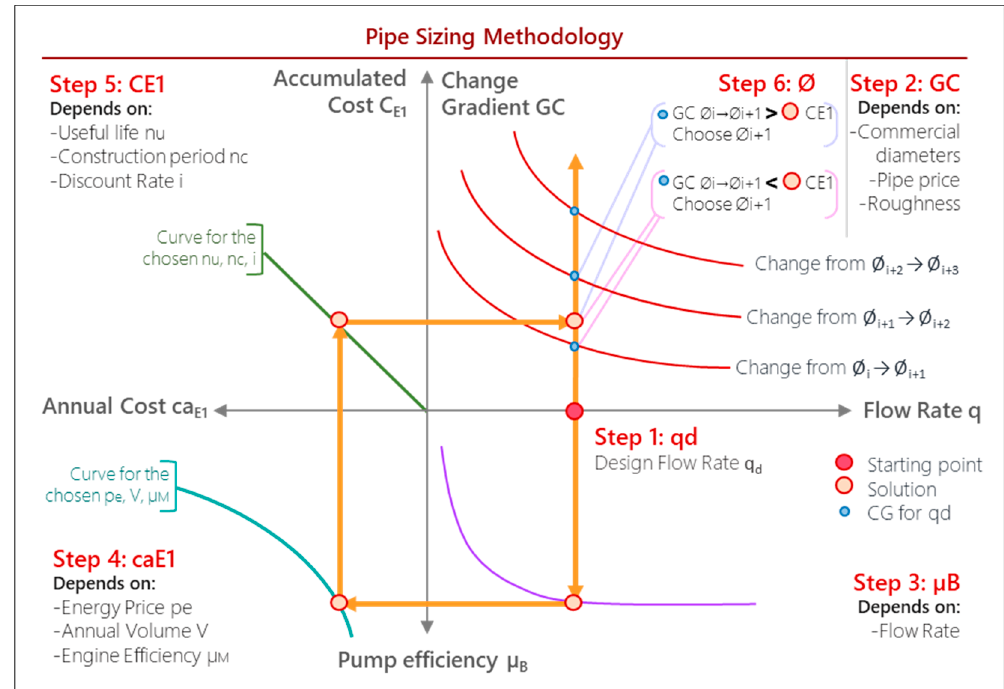
Figure 7. Pipe sizing methodology representing the steps for the design and the shapes that curves might present depending on the variables.